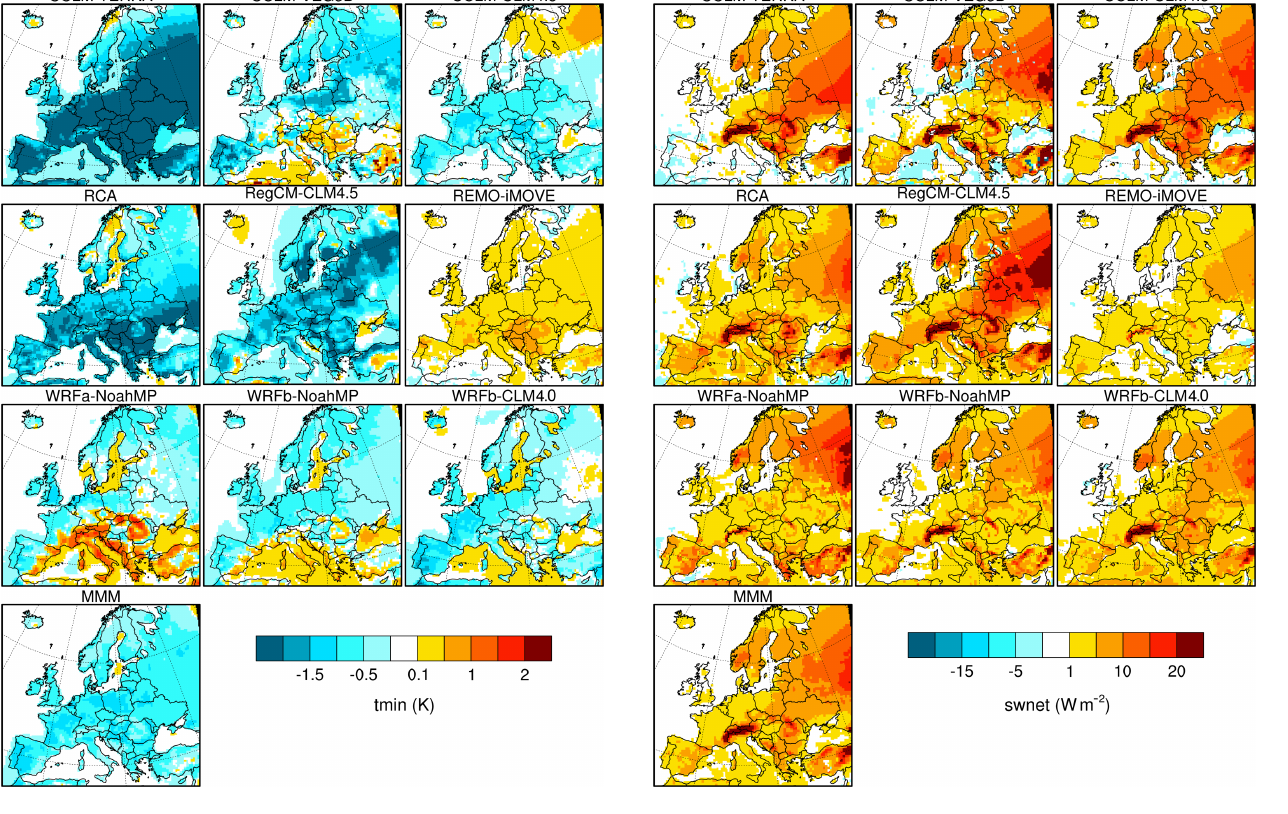
Figure 6. Seasonally averaged daily minimum 2m temperature (FOREST minus GRASS) for summer (JJA).